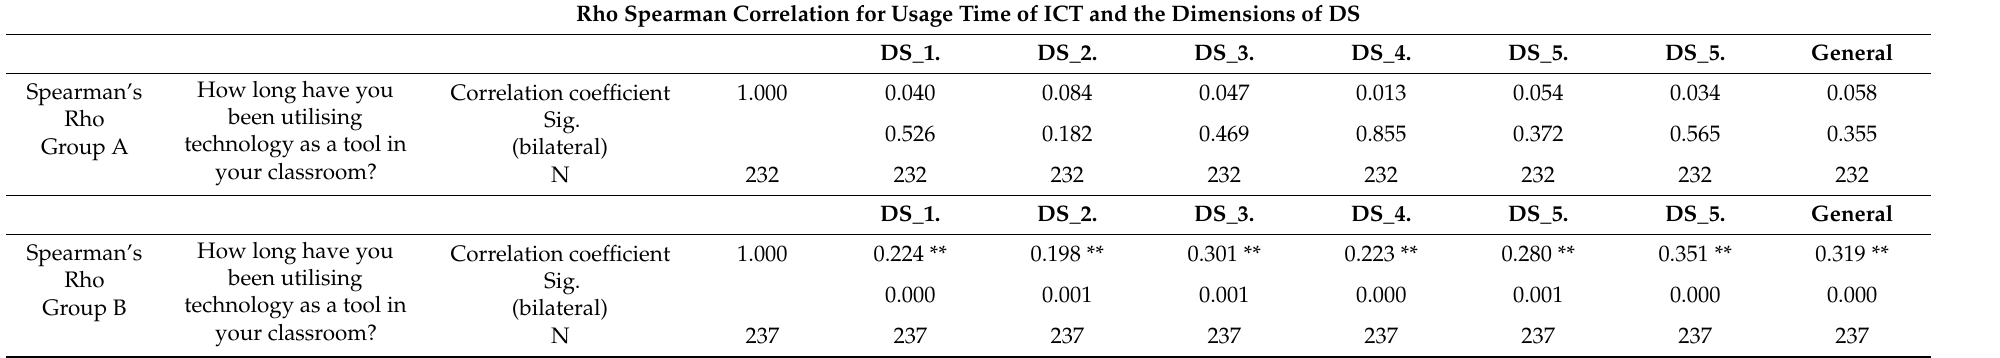
Table 10. Rho Spearman Correlation for usage time of ICT and the dimensions of DS in both groups A and B. Rho Spearman Correlation for Usage Time of ICT and the Dimensions of